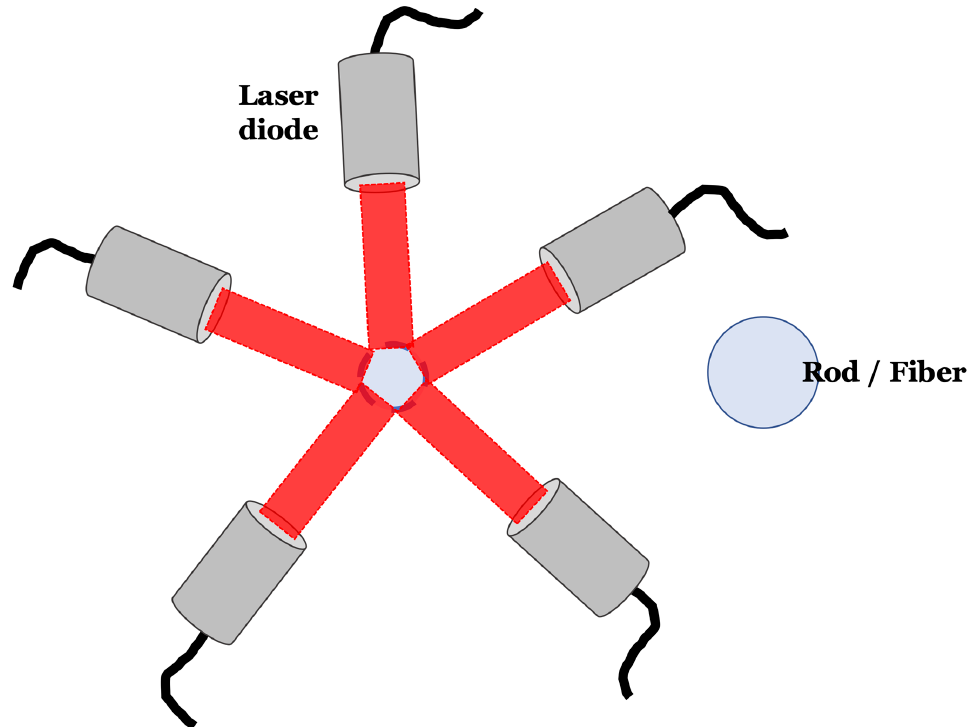
Figure 4. Top-view schematic drawing based on the Laser Diode Floating Zone (LDFZ) equipment designed by Ito et al., in 2013 [22], provided with five laser diodes, allowing a uniform irradiation intensity distribution on the periphery of the raw material